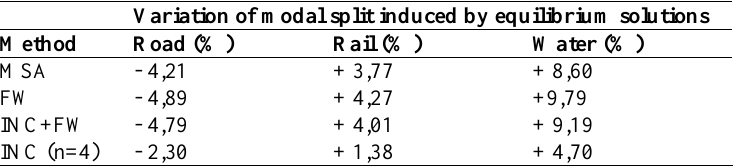
Figure 9. Assignment results on a stressed real case Table 8. Modal split on the stressed